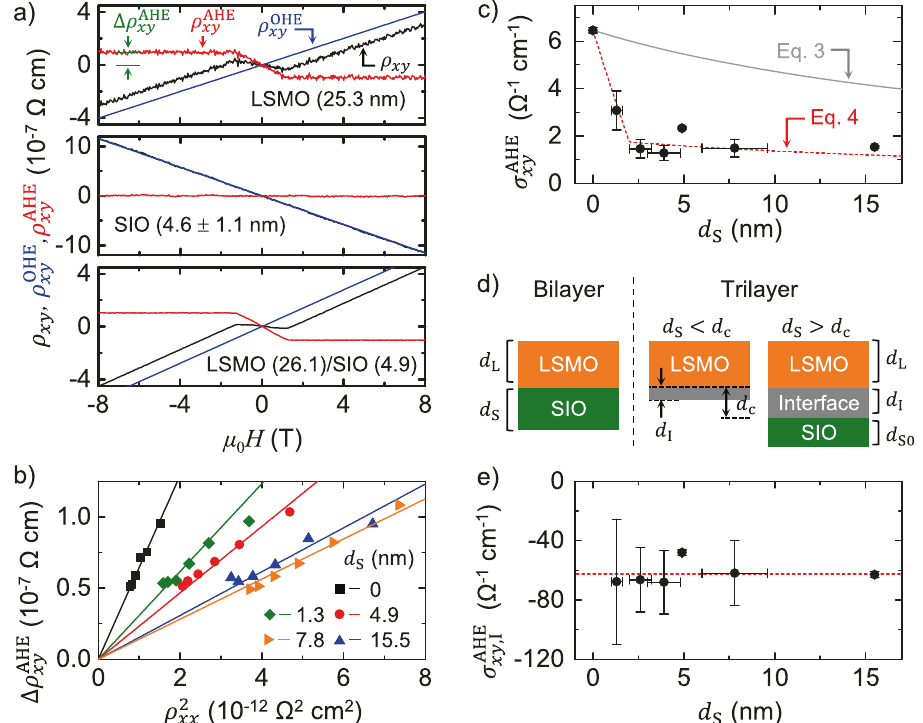
Fig. 2 Hall effect measurement and analysis. a Transverse Hall resistivity ρ xy vs. out of the plane magnetic fi eld, H z , (black lines) of La 0.7 Sr 0.3 MnO 3 25.3 nm (upper panel) and SrIrO 3 4.6 ± 1.1 nm (middle panel) thin fi lms and an LSMO (26.1 nm)/SIO(4.9 nm) bilayer (lower panel) measured at T = 100 K. Ordinary Hall resistivity ρ OHE xy (blue lines) and anomalous Hall resistivity, ρ AHE xy (red lines) have been separated. Δ ρ AHE xy indicates the value of ρ AHE xy at magnetic saturation (green arrow) b Δ ρ AHE xy vs. ρ 2 xx of La 0.7 Sr 0.3 MnO 3 /SrIrO 3 bilayers for different thicknesses d S of SrIrO 3 (symbols). Δ ρ AHE xy and ρ xx are measured at T = 20, 35, 50, 65, 80, and 100 K for each